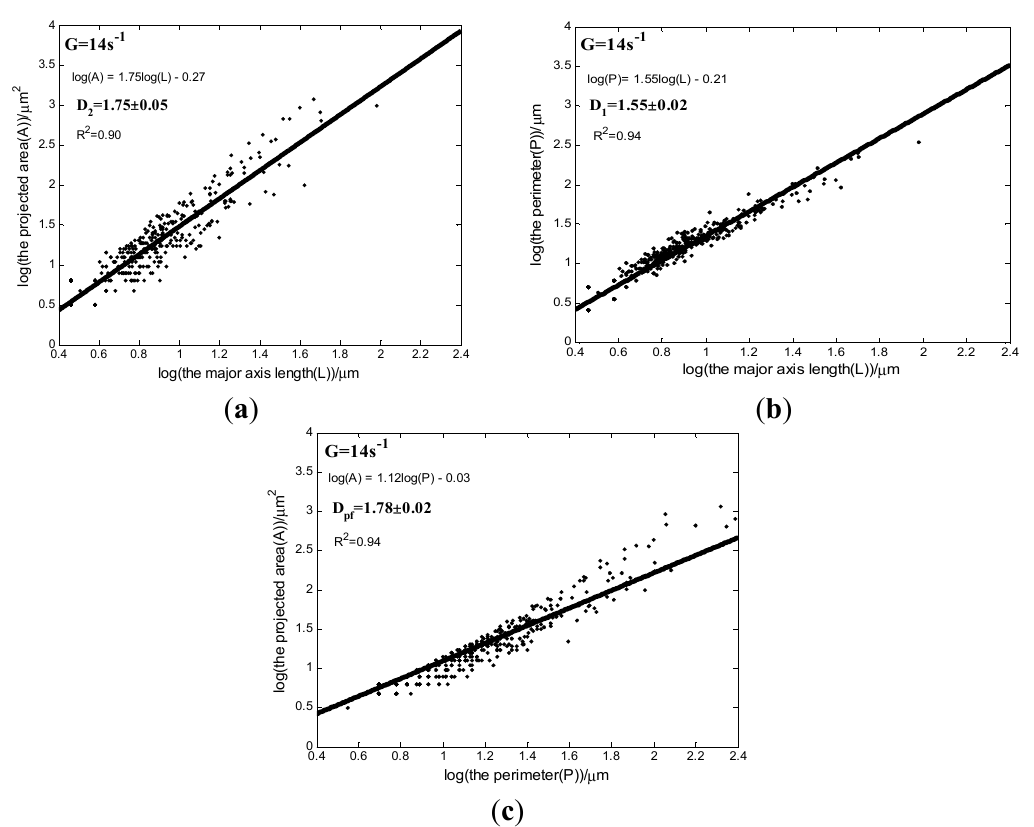
Figure 3. Determinations of 2-D ( a ), 1-D ( b ) and perimeter-based ( c ) fractal dimensions of the flocs as a representative example, which were formed for G = 14 s − 1 and ϕ = 7.87 × 10 − 5 at a time of 160 min (steady state) without electrolyte added into the suspension, based on measurement data of major axis length, the perimeter and the projected surface area of the flocs using the image processing